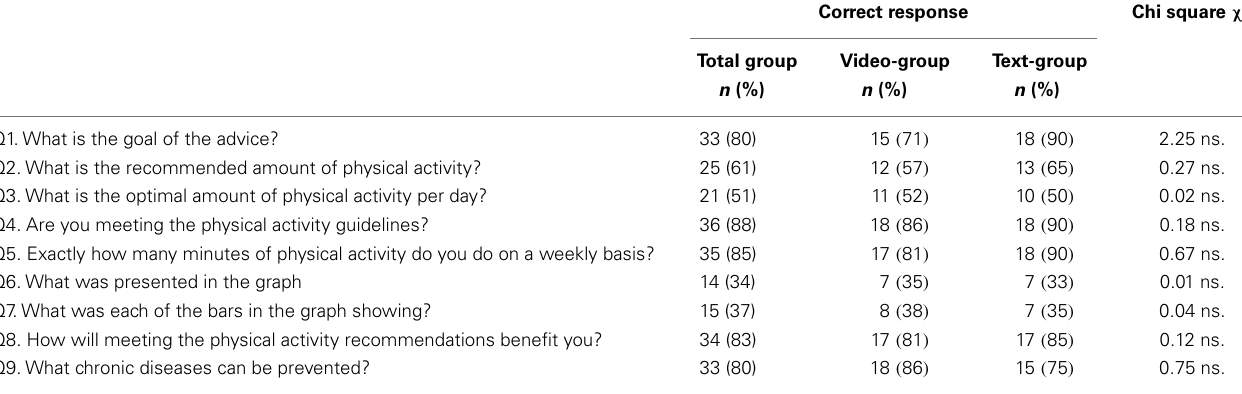
Table 3 | Correct responses for each recall question by group and chi square comparison of correct responses in video- and text-groups